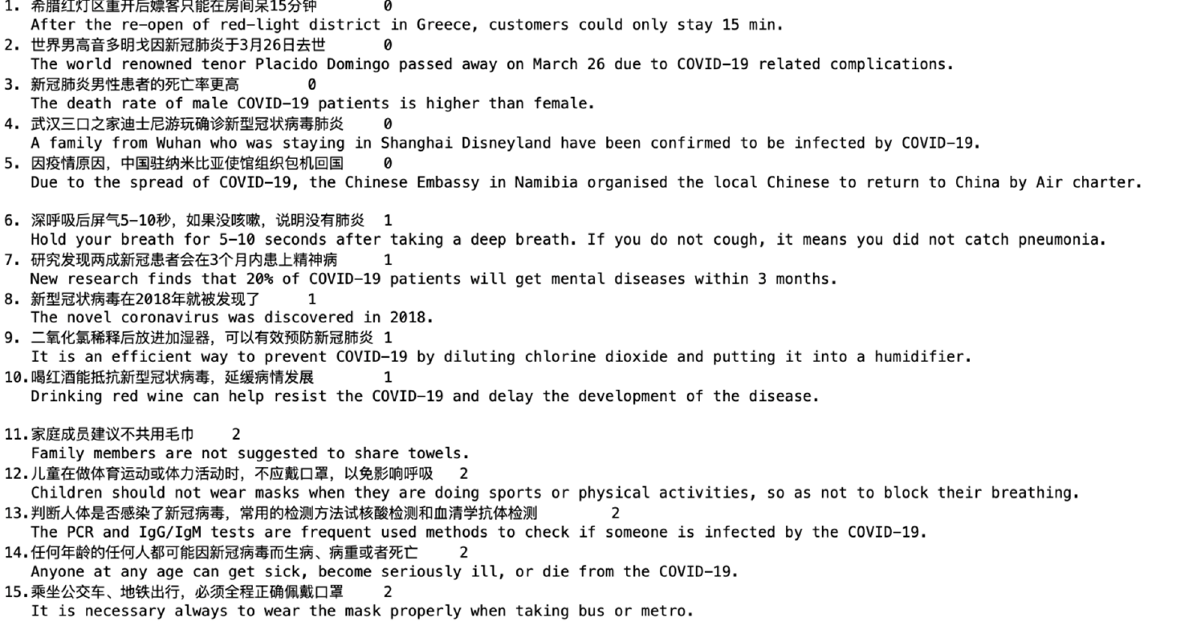
Figure 3. Representative instances of the infodemic 2019 dataset and the corresponding translation in English.